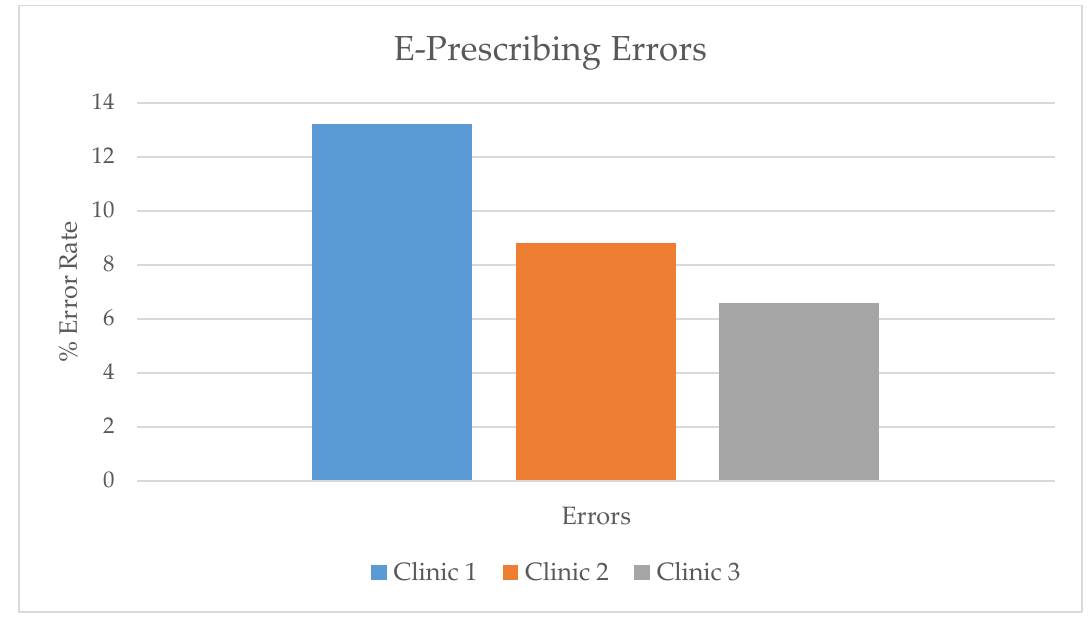
Figure 1. Total e-prescribing errors per clinic.